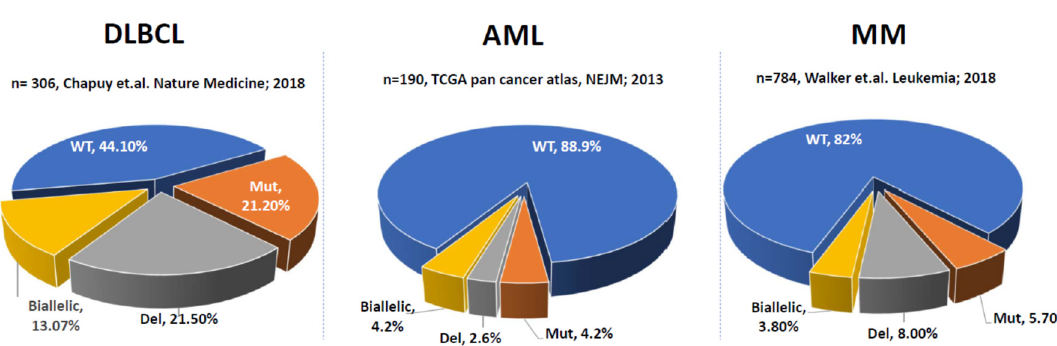
Figure 1. Prevalence of wild-type (WT), deletion (del), mutation (mut), and biallelic inactivation of TP53 in select hematologic malignancies, DLBCL ( left ), AML ( middle ), and MM ( right ). 3. Prognosis of Del17p / TP53 Inactivation in Multiple